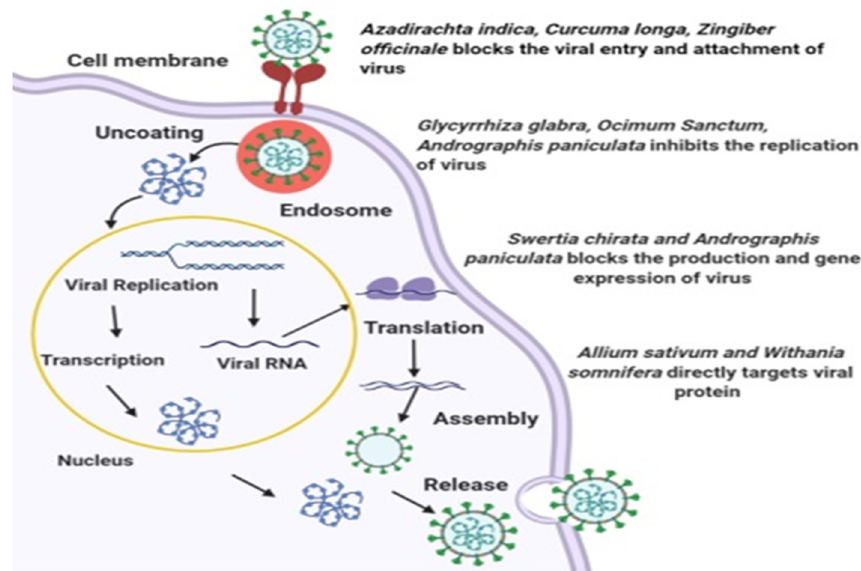
Figure 3. Possible antiviral mechanism of Indian medicinal plants.